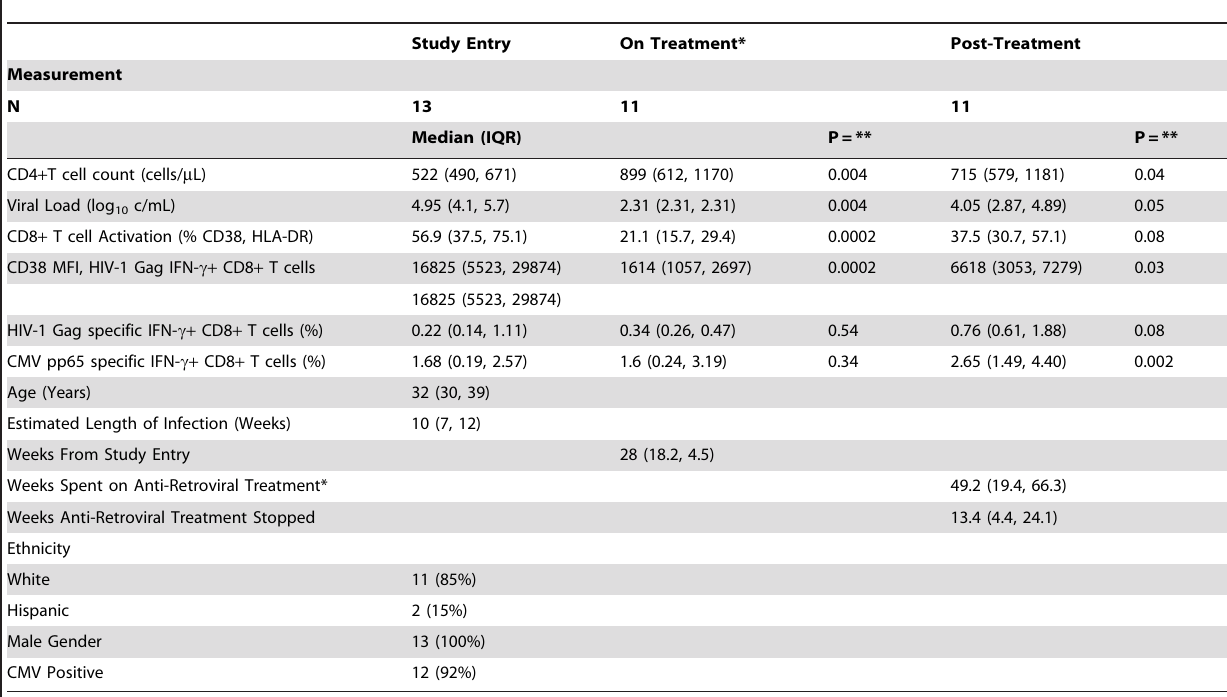
Table 1. Demographic, Clinical and Laboratory Measures By Study